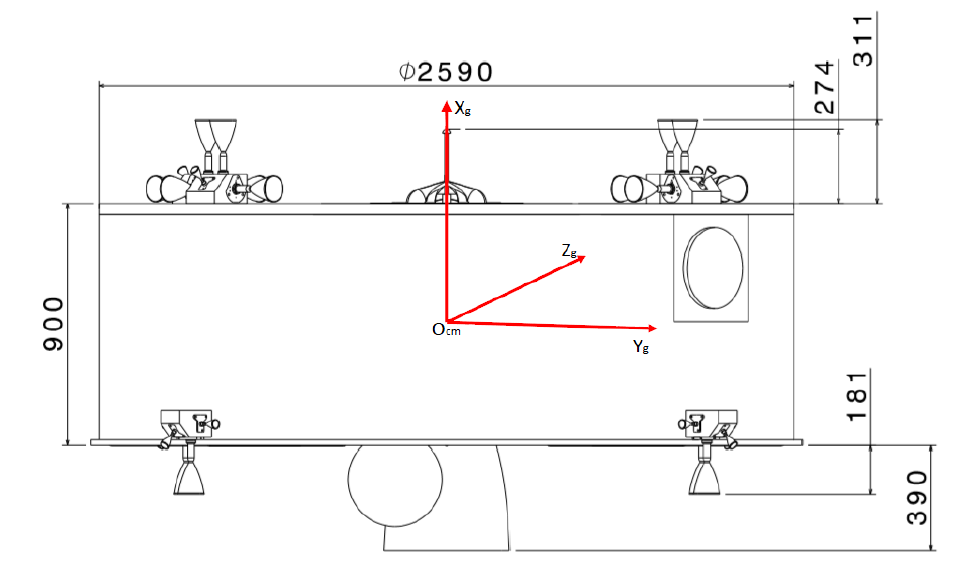
Figure 21. CAD rendering of the chaser thruster architecture-side